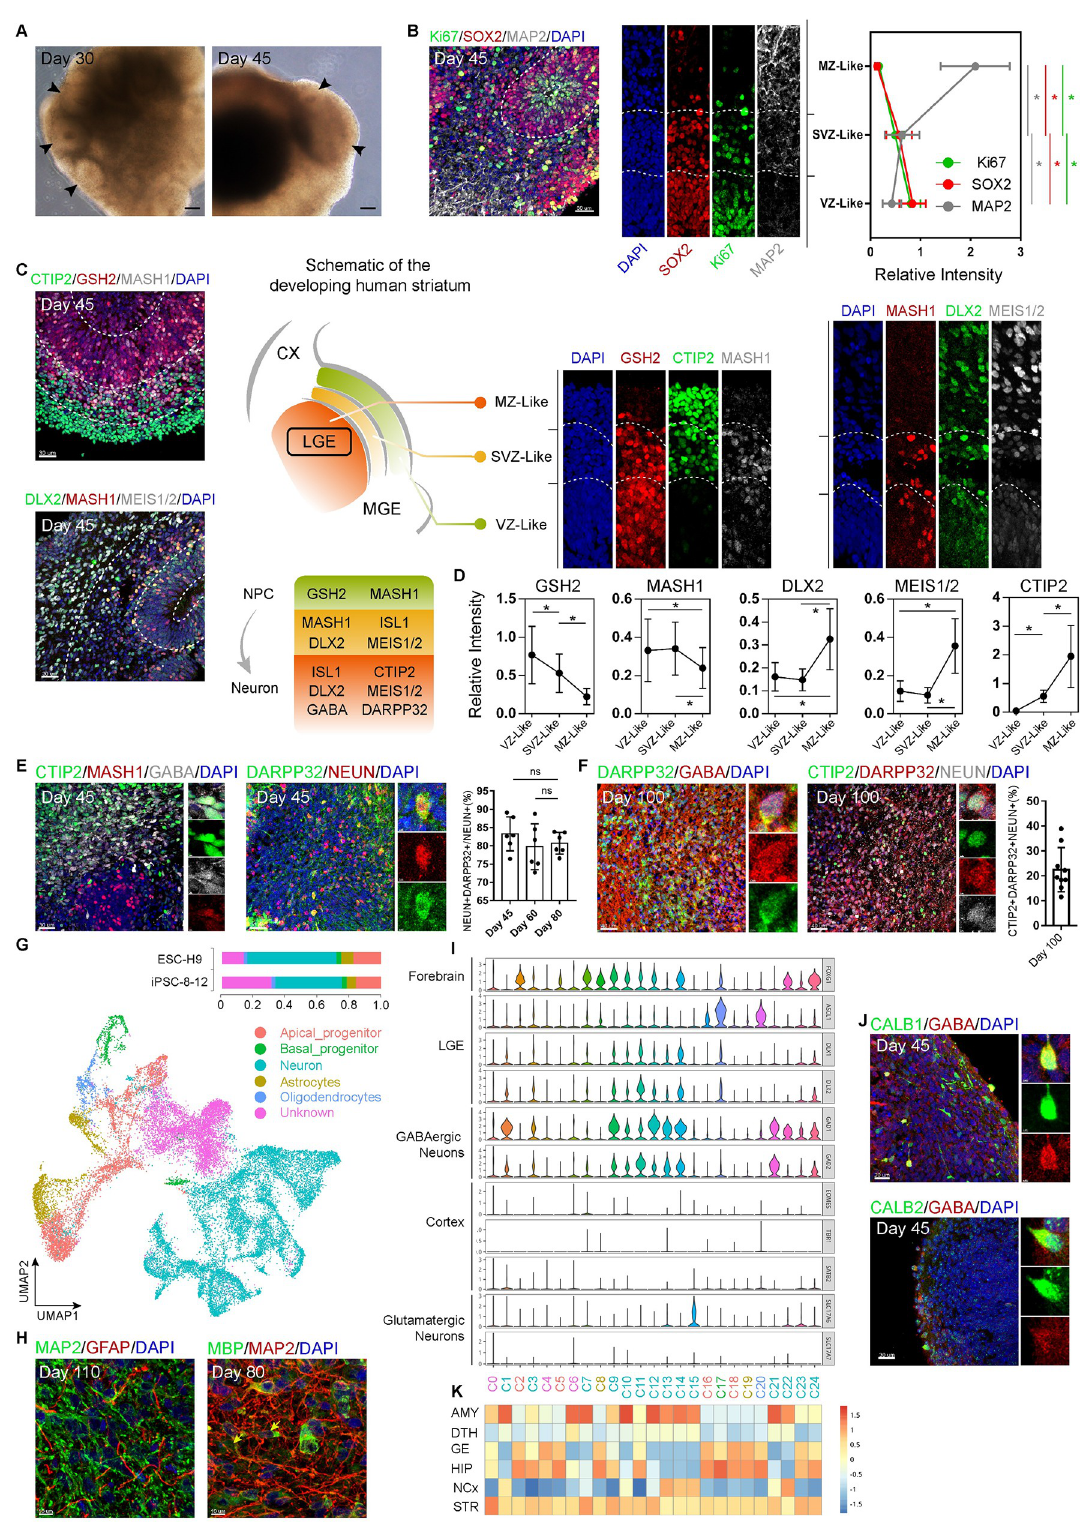
Fig 2. hStrO development mimics LGE development. (A) Typical bright-field images of the hStrO were captured on Days 30 and 45 (arrows, the neural rosette-like structures). Scale bar, 100 μ m. (B) Immunostaining for Ki67, SOX2, and MAP2 antibodies in Day